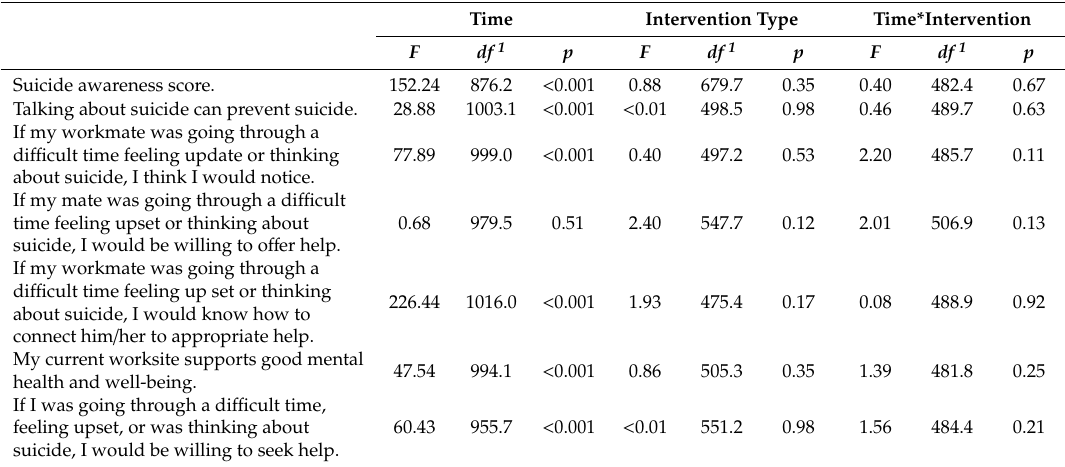
Table 1. Fixed e ff ect estimates for suicide awareness.